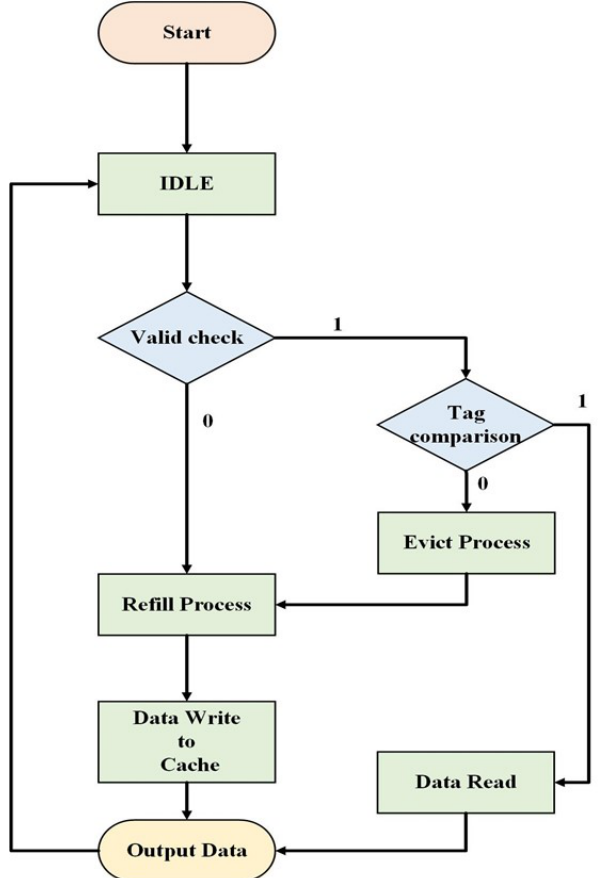
Figure 9. Flow chart of direct-mapped cache system.